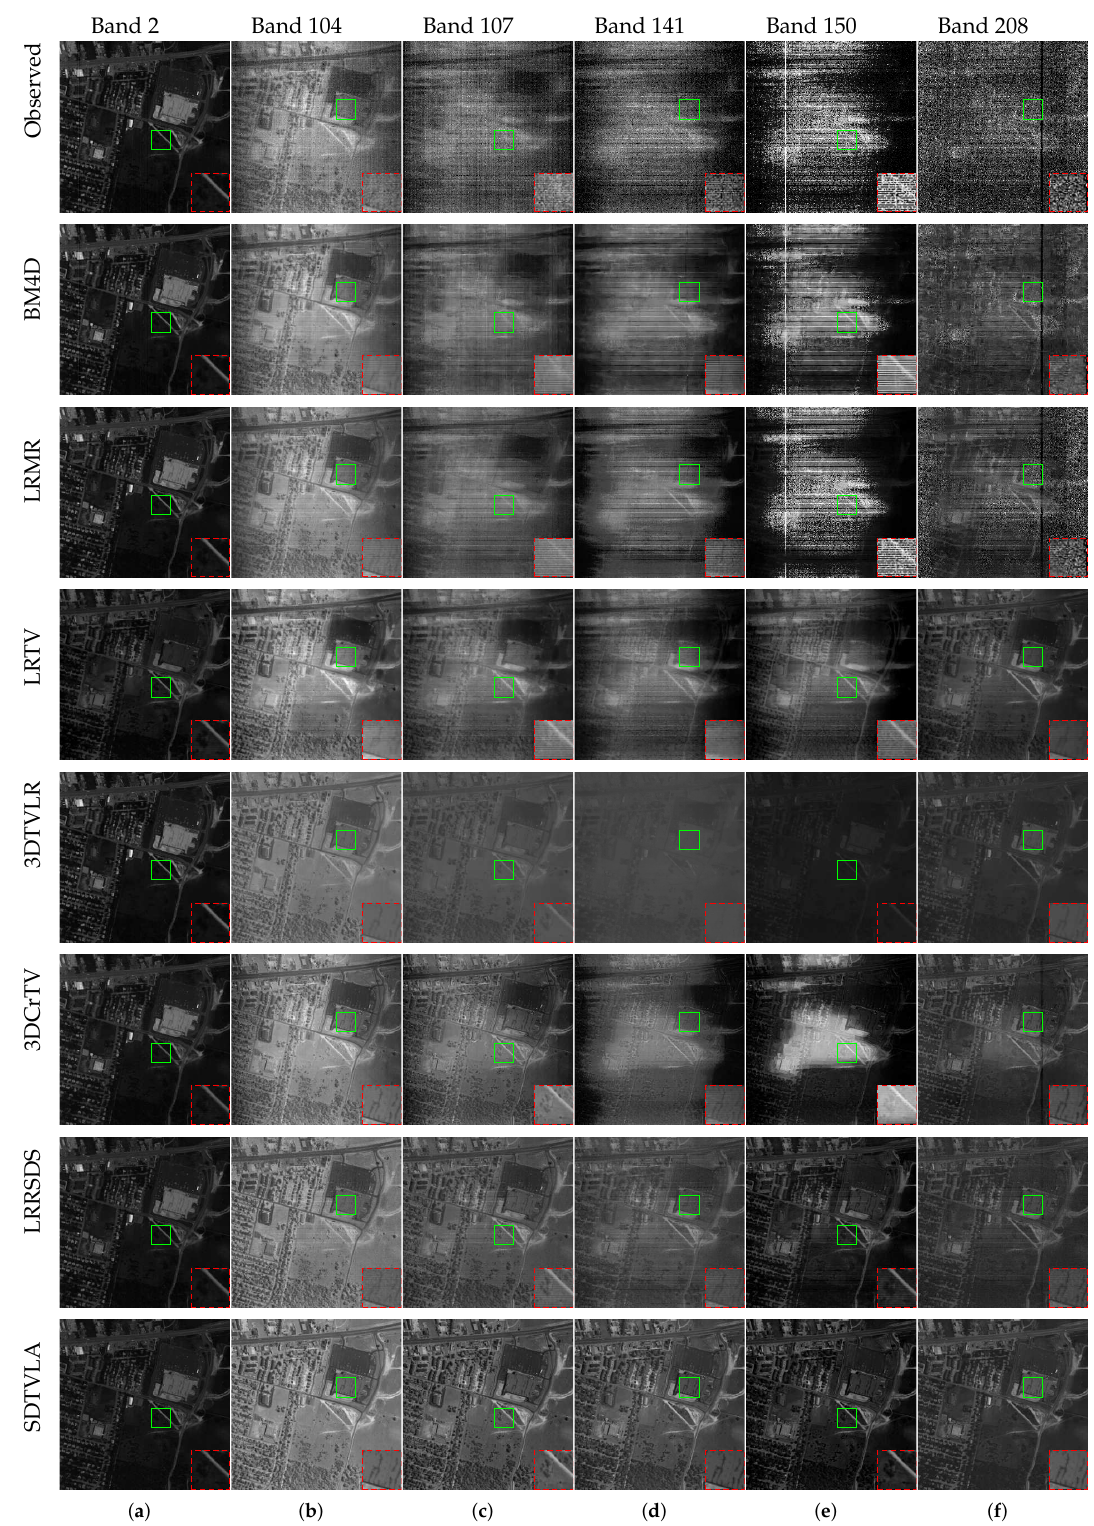
Figure 9. Denoising results of the competitive methods in Urban dataset (Zoom in to see the details